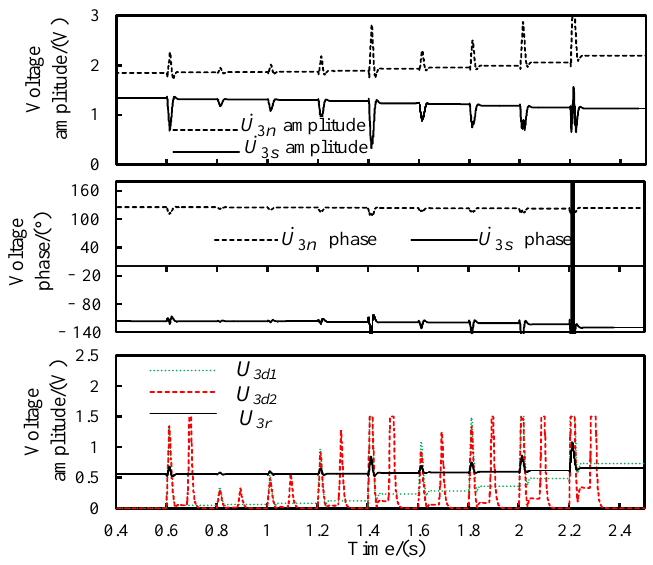
Figure 11. Trip calculation when the winding (somewhere α is 0.67) is grounded via a varied resistor.